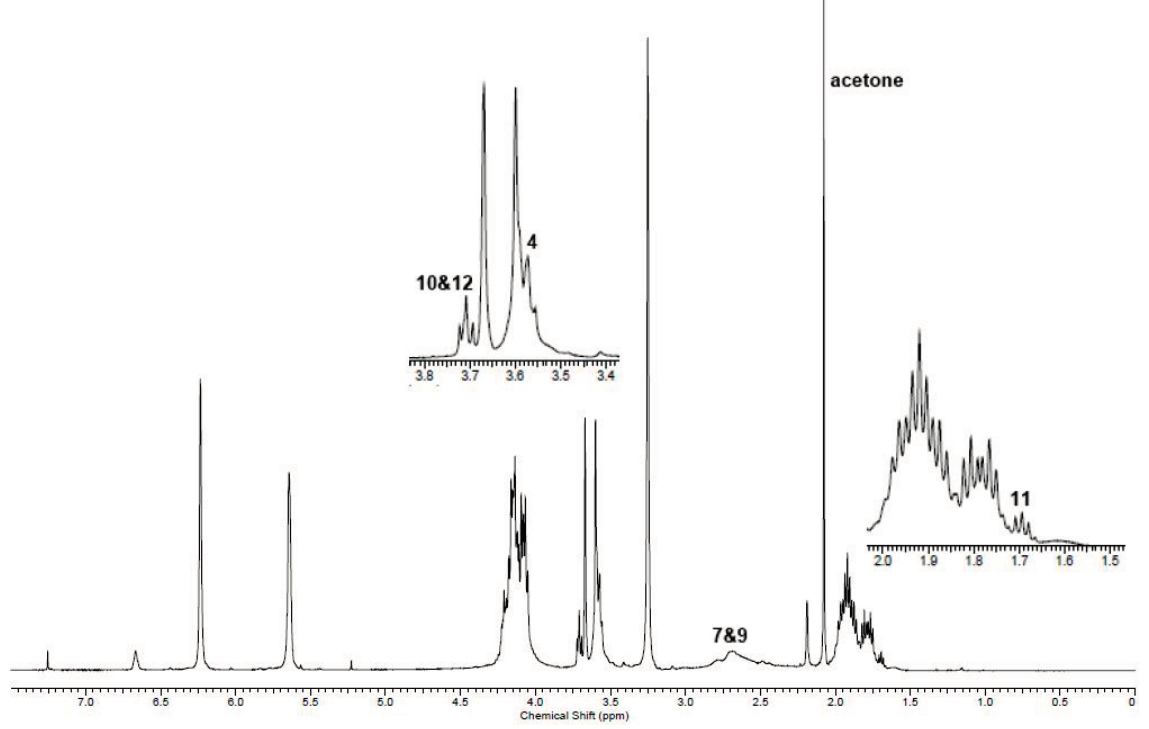
Figure 4. 1 H NMR spectrum for the branched unsaturated form of PPI. The